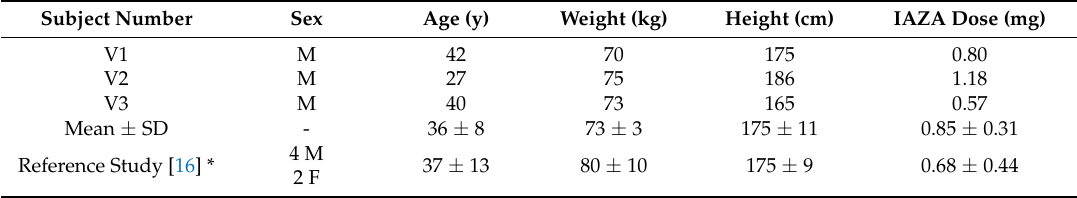
Table 1. Exercise-stressed healthy volunteer demographics and individual IAZA doses. Each subject received a nominal 5 mCi injection of [ 123 I]IAZA. Published data for rested volunteers [16] are included for comparison.